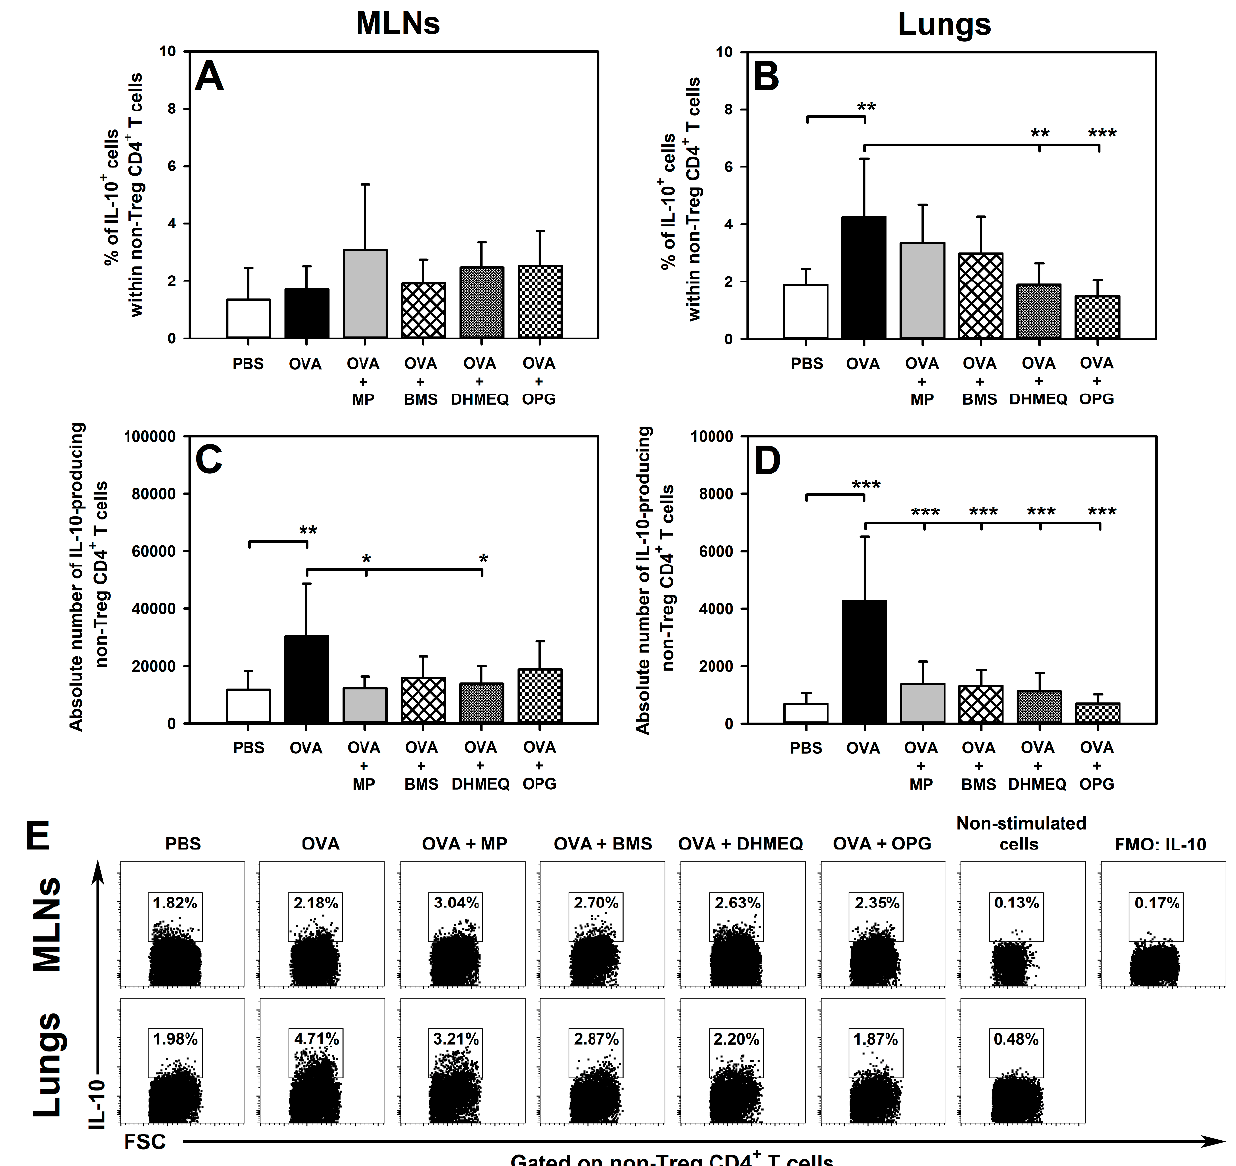
Figure 2. Effect of inhibitors of IKK (BMS-345541 (BMS)), NF- κ B translocation (dehydroxymethylepoxyquinomicin (DHMEQ)) and RANK/RANK-L interaction (osteoprotegerin (OPG)), and glucocorticosteroid (methylprednisolone (MP)) administration on the number of IL-10-producing non-Treg CD4 + T cells. The relative count ( A , B ) is expressed as a per- centage of IL-10-producing cells within non-Foxp3 + CD25 + CD4 + T cells. The absolute count ( C , D ) represents the number of IL-10-producing non-Foxp3 + CD25 + CD4 + T cells per MLN or lung sample collected from individual mice. * p < 0.05, ** p < 0.01, *** p < 0.001. Examples of dot plot cytograms showing the distribution of IL-10-producing and non-producing cells within non-Treg CD4 + T cells ( E ).